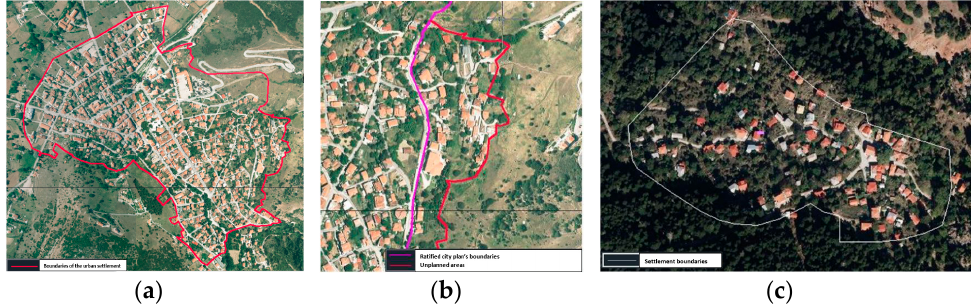
Figure 4. ( a ) Digitization of city’s boundaries, with ratified city plan. ( b , c ) Digitization of the boundaries of the unplanned settlements. Source: [35].